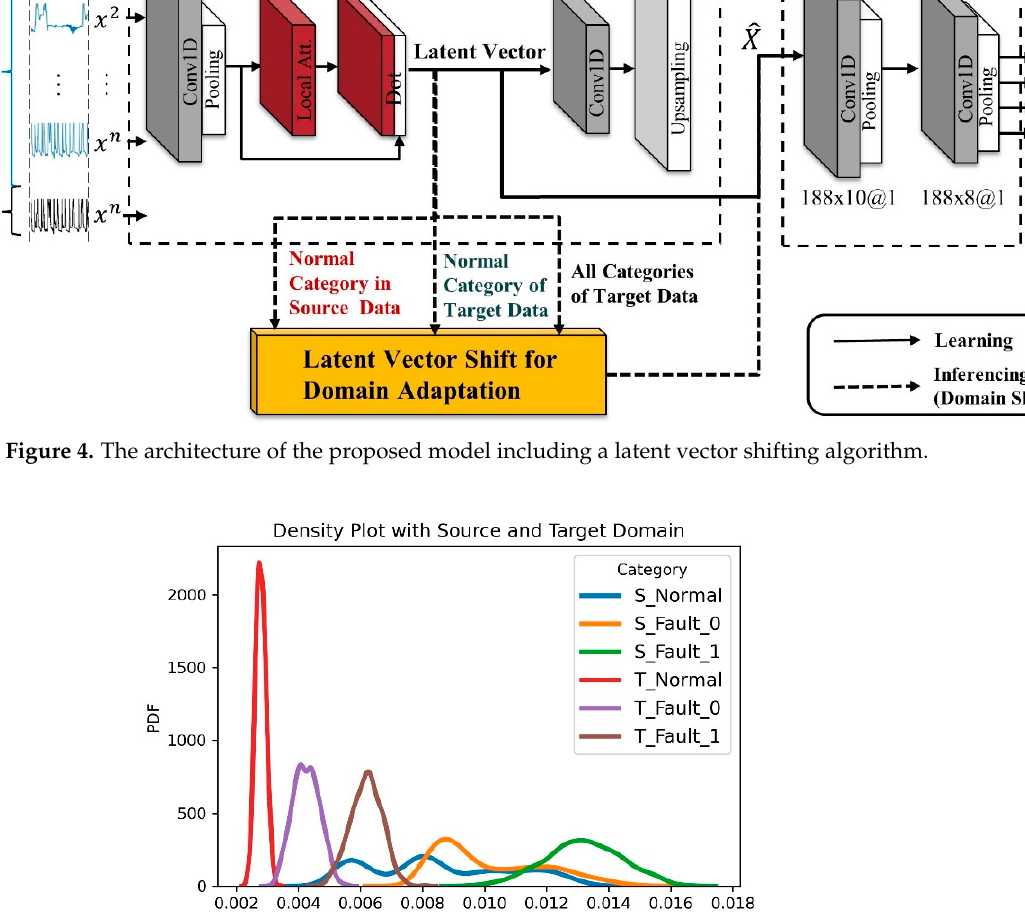
Figure 4. The architecture of the proposed model including a latent vector shifting algorithm.